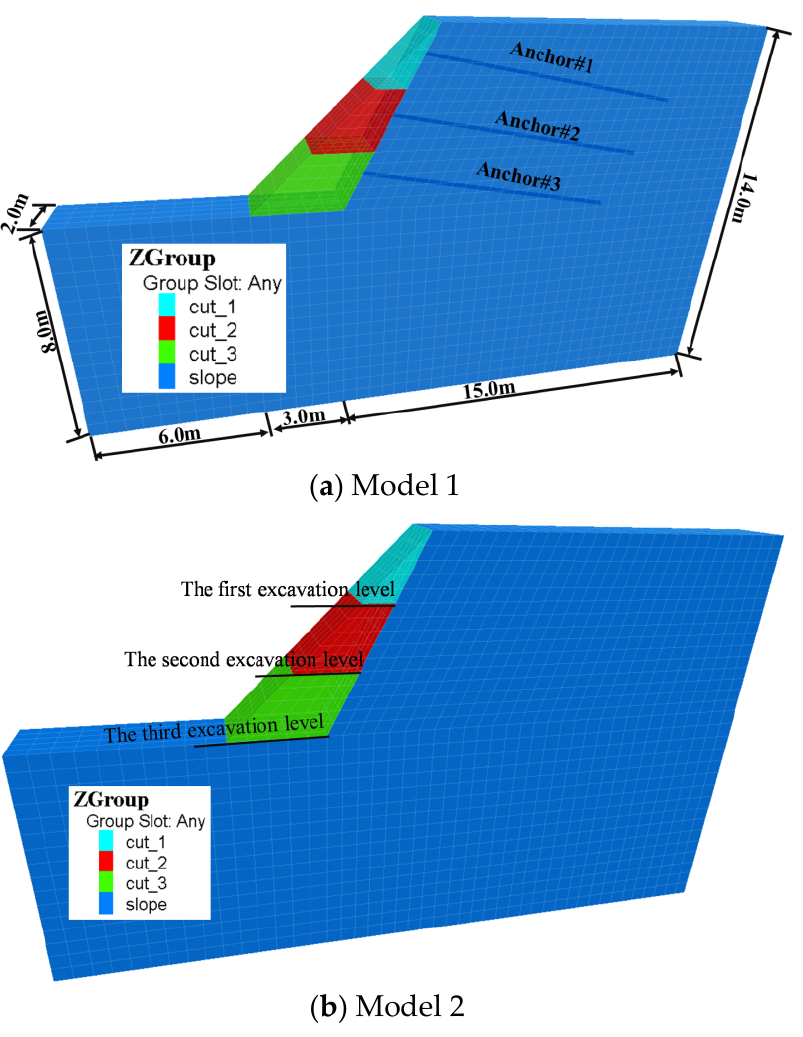
Figure 4. Numerical calculation models. Table 1. Calculation stages for both